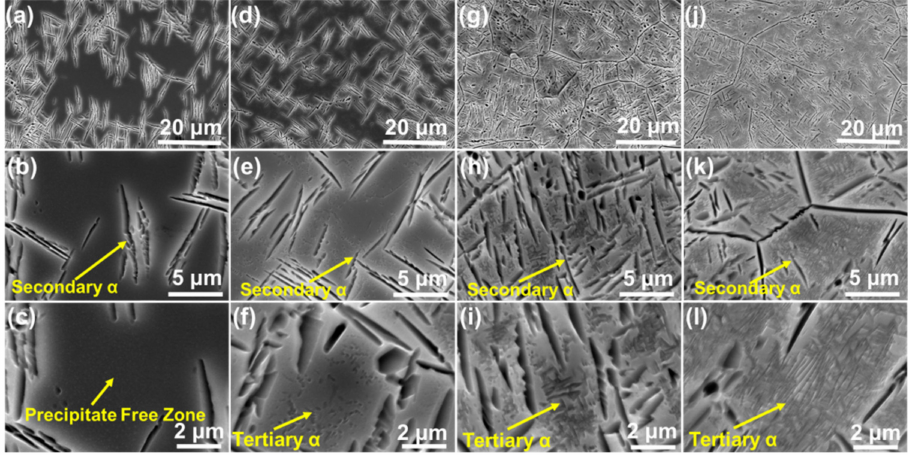
Figure 3. Microstructures of the alloy after HLDA (second-step aging) for different time at 450 ◦ C: